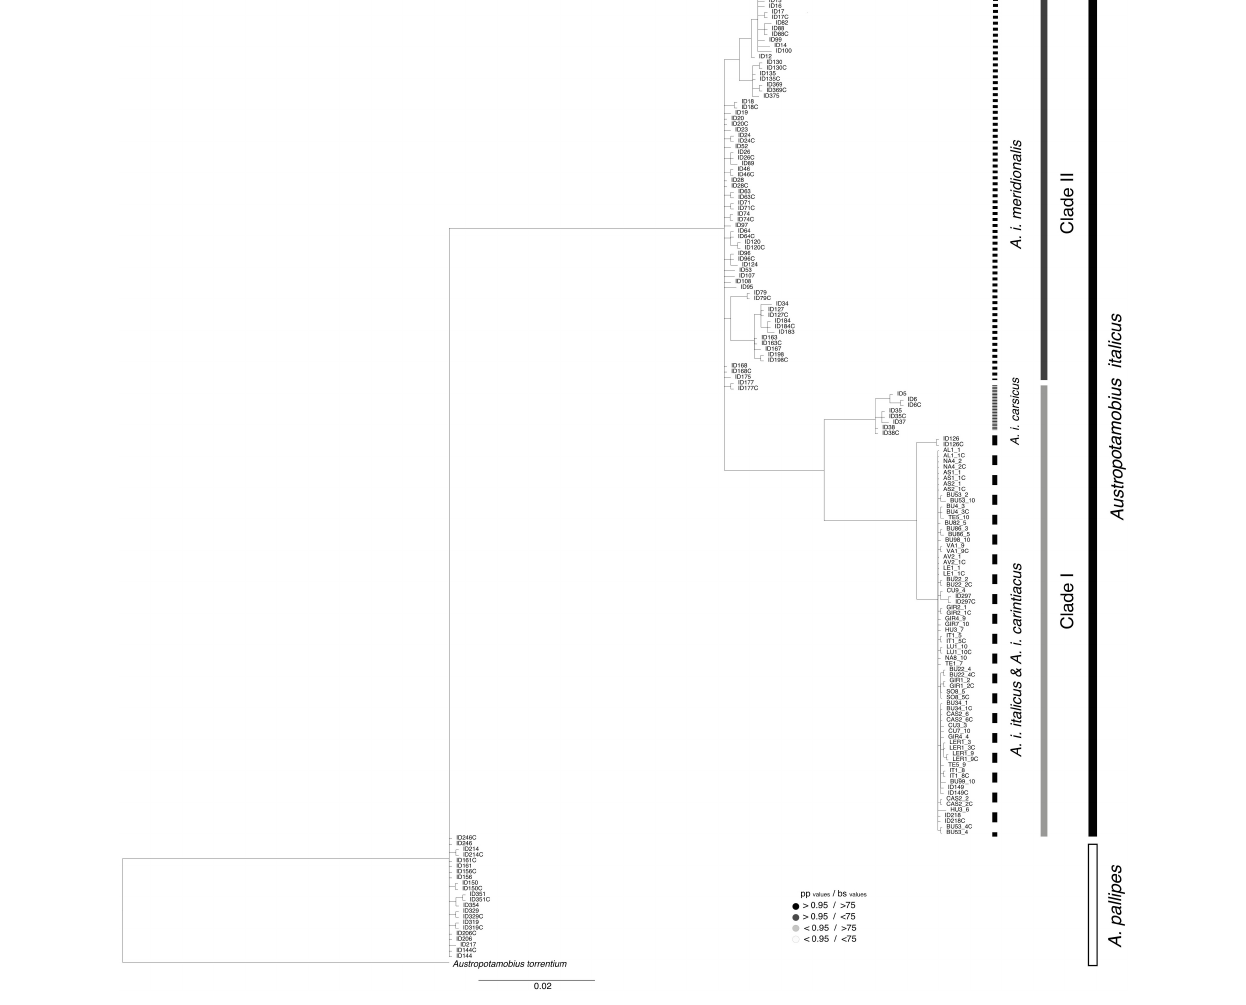
FIGURE 1 | Bayesian inference analyses based on concatenated mitochondrial 16S rRNA and COI genes sequences from Data Set 1. The posterior probability values (pp values) are from Bayesian inference analysis and the bootstrap support values (bs values) from Maximum Likelihood. Nodes with black circles have pp values higher than 0.95 and bs higher than 75, nodes with dark gray circles have pp higher than 0.95 and bs lower than 75, nodes with light gray circles have pp lower than 0.95 and bs higher than 75, and nodes with white circles have pp lower than 0.95 and bs lower than 75. Scales bar for phylogenetic analysis indicates substitutions per